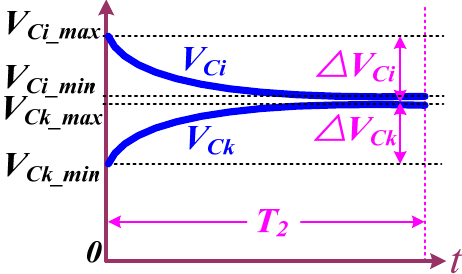
Figure 6. Capacitor voltage waveform for the phase Φ 2 .